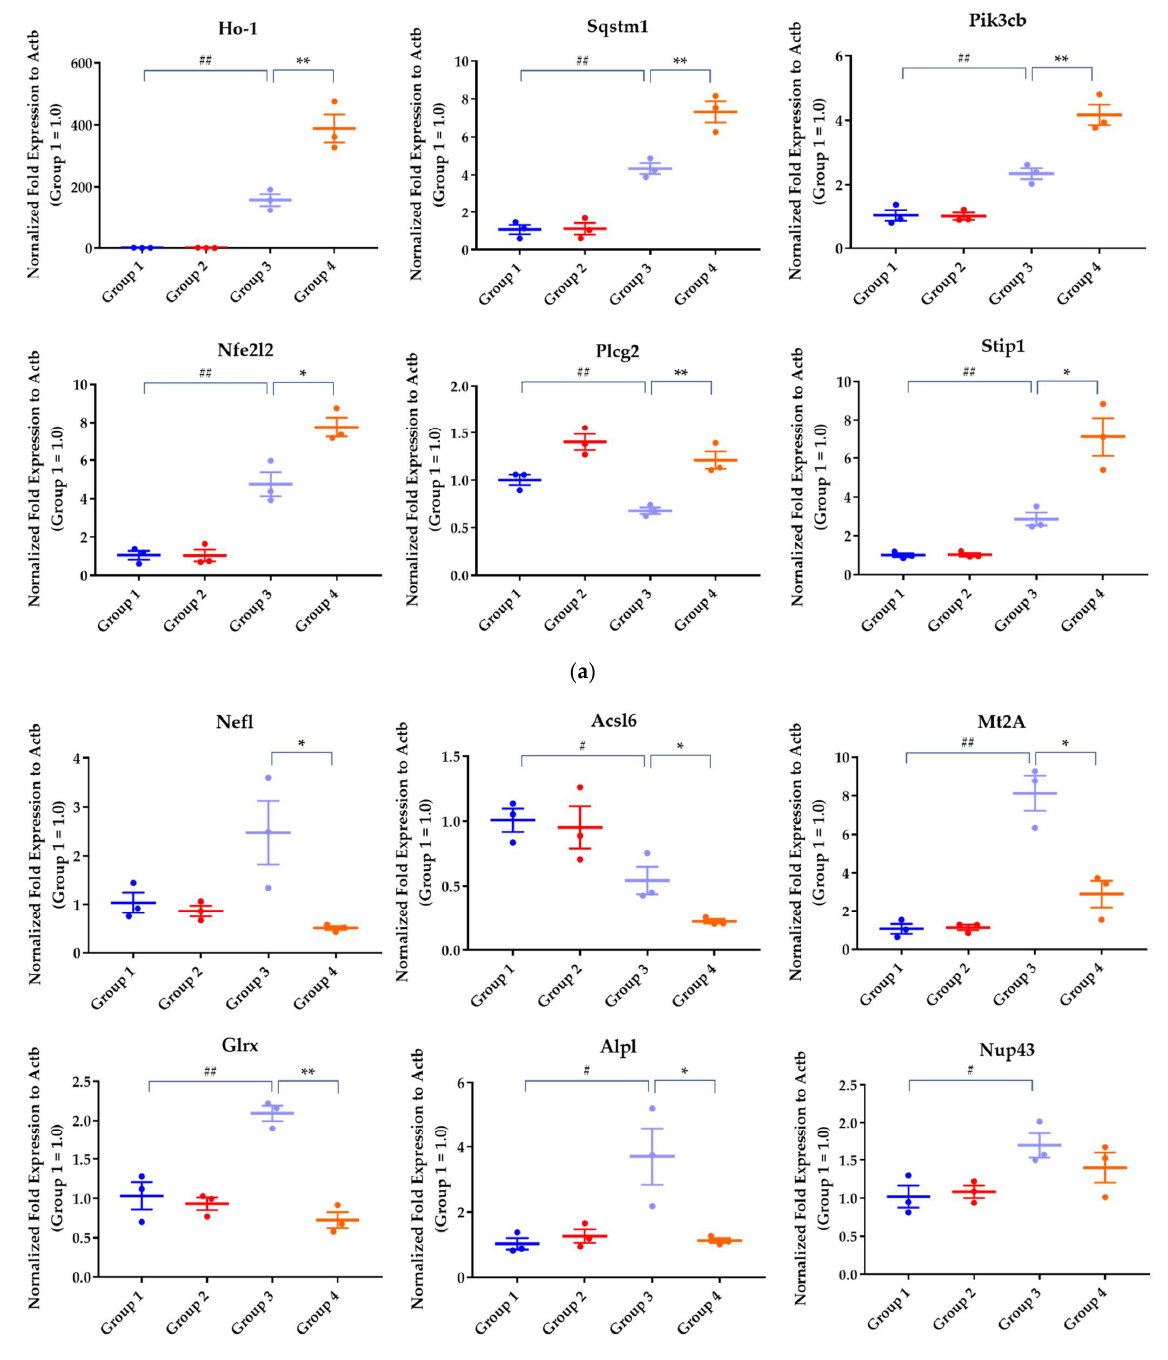
Figure 6. qPCR analysis of representative genes. ( a ) Upregulated and ( b ) downregulated genes upon edaravone treatment. Data are represented as mean ± standard error of the mean (n = 3 in 3 experiments). At first, Group 1 (Control) and Group 3 (TDP-43 + EA) were compared to find the effect of proteinopathy using a Student’s t -test # p < 0.05, ## p < 0.01. Then, the difference between Group 3 and Group 4 (TDP-43 + EA + Eda) was analyzed to find the effect of edaravone on proteinopathy-induced changes using a Student’s t -test. * p < 0.05, ** p <